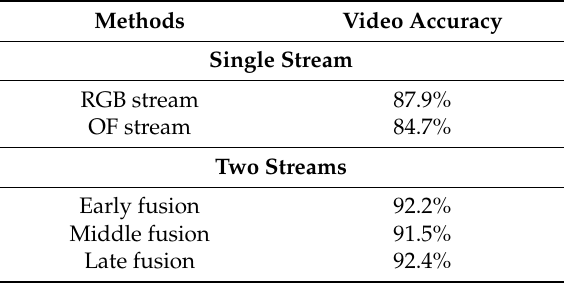
Table 4. Comparison of single stream with two streams in the 8f temporal scale on UCF101 split-1. Methods Video Accuracy Single